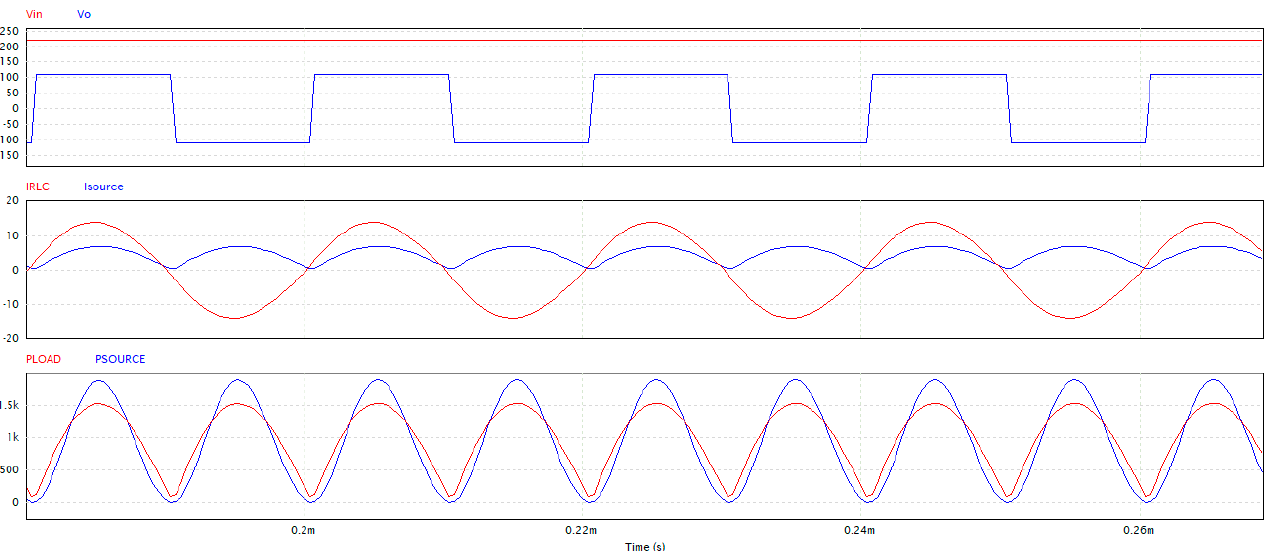
Figure 13. Switching waveforms for non-ferrous heating mode during simulation.